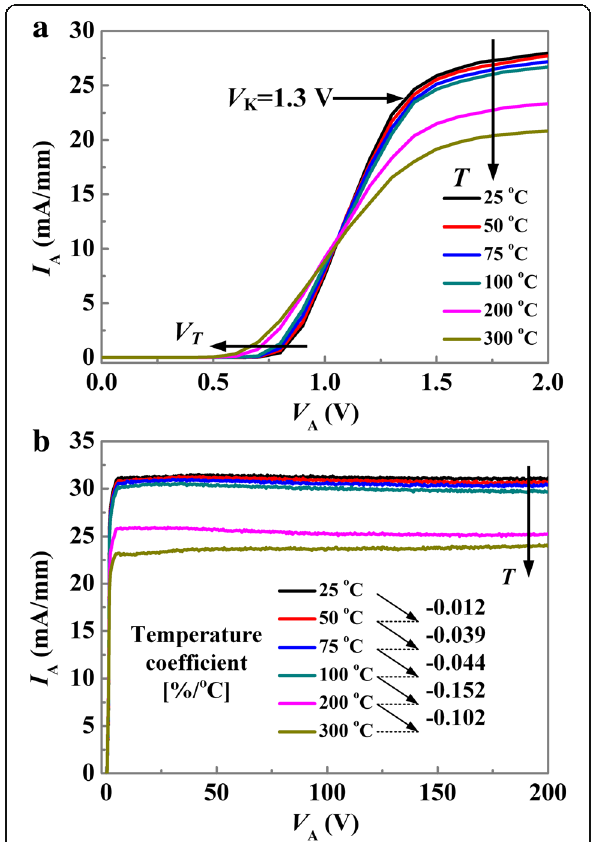
Fig. 5 Temperature dependent forward bias I - V characteristics of the RB-CRD. Anode voltage ranges: a 0 – 2 V, b 0 – 200